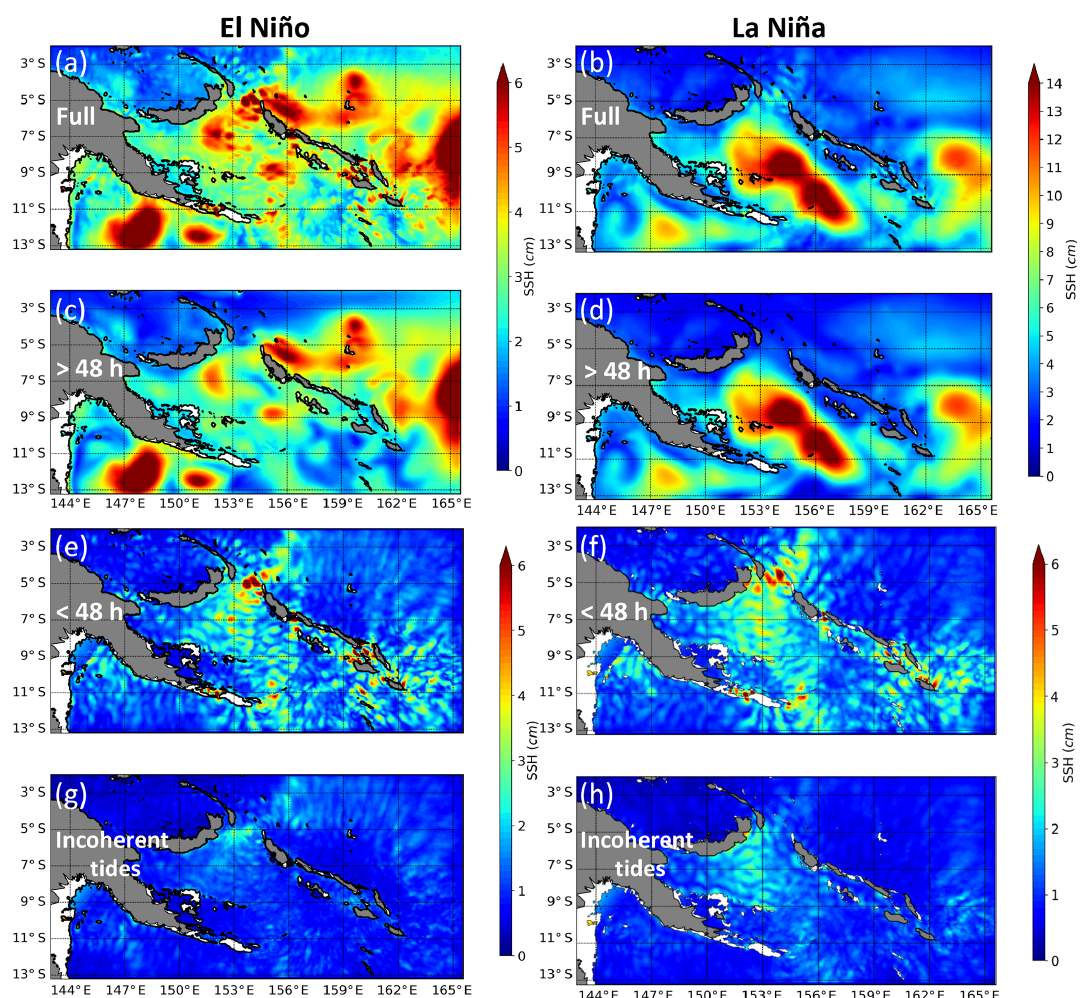
Figure 3. Root mean square of SSH variability for the 3-month periods of the (a, c, e, g) El Niño state and (b, d, f, h) La Niña state. Units are in centimeters. The top panel (a, b) is the full SSH variance, the second panel (c, d) is the mesoscale variability (periods > 48h), the third panel (e, f) is the high-frequency variability (periods < 48h), dominated by the internal tides (both coherent and incoherent components), and the bottom panel (g, h) is the incoherent internal tide variability. Note the change of color bar for the full and mesoscale variability in the La Niña period. Isobathymetric lines are from the NOAA/ETOPO2v2 bathymetric file from the Smith & Sandwell database (https: //doi.org/10.7289/V5J1012Q, National Geophysical Data Center, 2006). White color is for bathymetry of less than